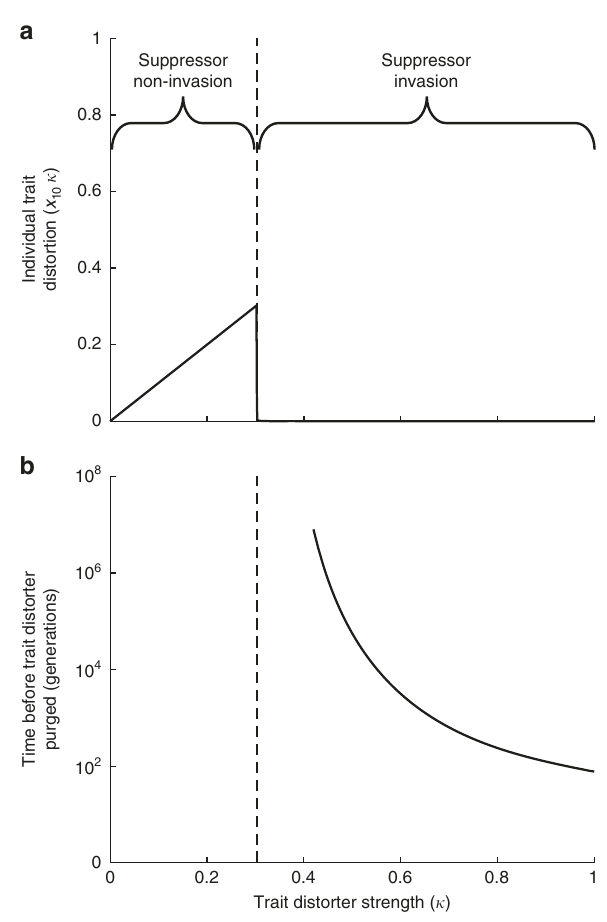
Fig. 1 Trait distorter-suppressor dynamics and consequences for the organism. The trait distorter ( D 1 ) and its suppressor ( S 1 ) are introduced from rarity. In a , the resulting average trait distortion ( x 10 k ) is plotted at equilibrium, against the extent to which the trait distorter causes trait values to deviate from the individual optimum ( k ). Below a certain threshold strength ( c sup > c trait ( k ); left of dashed line), the suppressor does not invade, and so the resulting trait distortion increases with the strength of the trait distorter ( k ). Above this threshold, the suppressor invades, and the trait distorter is purged, restoring the trait to the individual optimum. In b , the number of generations between trait distorter introduction and loss is plotted, on a log 10 scale, for trait distorters that are purged at equilibrium (having been suppressed), which lie to the right of the dashed line. Stronger trait distorters are purged more quickly than weaker trait distorters ( c sup = 0.15; t = 0.87 k and c trait = 0.9 k 1.5 ) show in Supplementary Note 6 that if the suppressor is constitutively expressed (obligate), the spread of the suppressor ( S 1 ) to fi xation in the population causes the trait distorter ( D 1 ) to become neutral, meaning the trait distorter ( D 1 ) can be maintained in the population without being expressed.